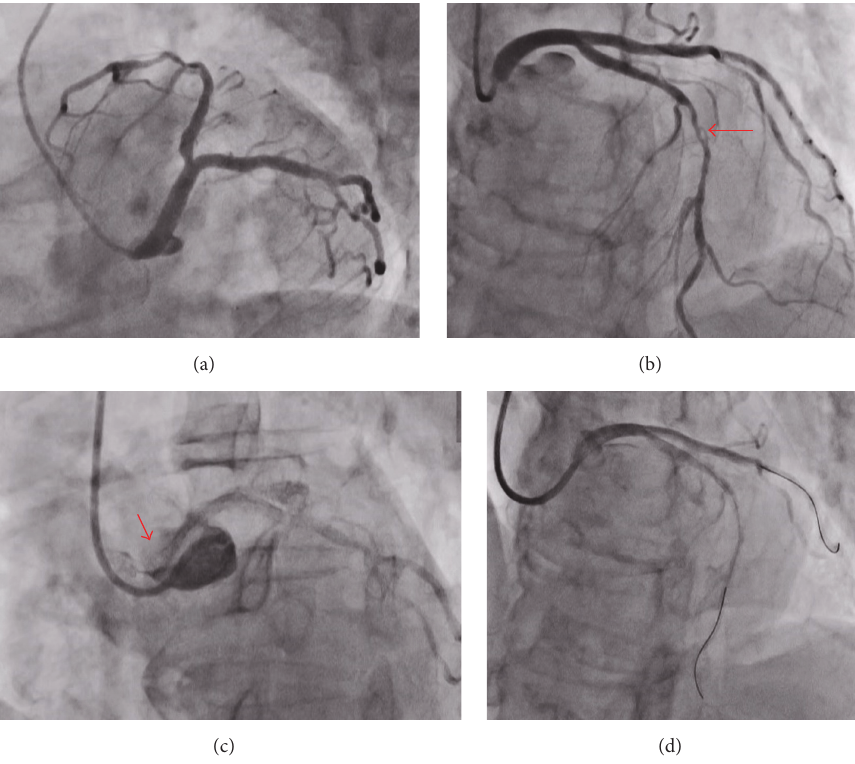
Figure 3: (a) Diagnostic coronary angiogram of the LCA (LAO/caudal view). (b) Diagnostic coronary angiogram of the LCA (LAO/cranial view). The arrow shows stenosis of the mid-LAD artery. (c) Cusp contrast injection with Amplatz-Left (LAO view). The arrow shows the ostium of the LCA. (d) Coronary angiogram with Judkins-Right guiding catheter with 2 wires.